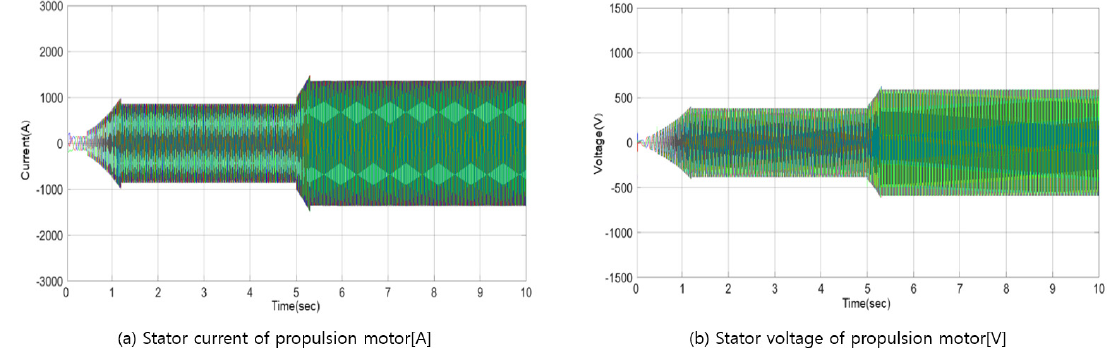
Figure 21. Simulation results of propulsion motor when load varies as 20 → 40%.